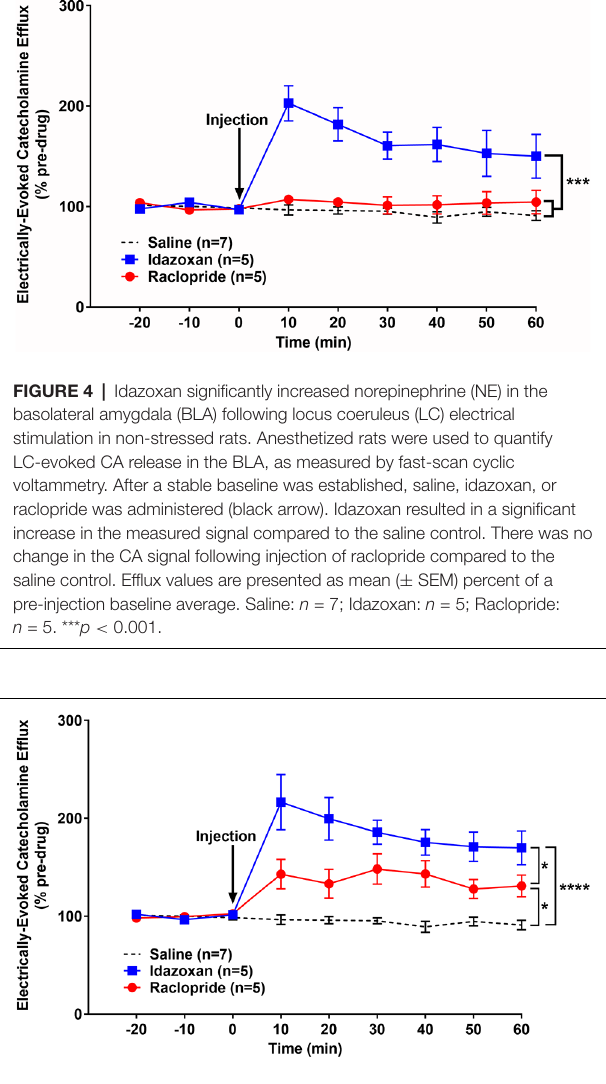
FIGURE 5 | Idazoxan and raclopride significantly increased norepinephrine and dopamine (DA), respectively, in the basolateral amygdala (BLA) following locus coeruleus (LC) electrical stimulation in rats exposed to repeated social defeat stress (RSDS). Rats exposed to 5 days of social defeat stress were anesthetized and used to quantify LC-evoked CA release in the BLA, as measured by fast-scan cyclic voltammetry. After a stable baseline was established, saline, idazoxan, or raclopride was administered (black arrow). Idazoxan and raclopride resulted in a significant increase in the measured signal compared to the saline control. Efflux values are presented as mean ( ± SEM) percent of a pre-injection baseline average. Saline: n = 7; Idazoxan: n = 5; Raclopride: n = 5. * p < 0.05; **** p < 0.0001.